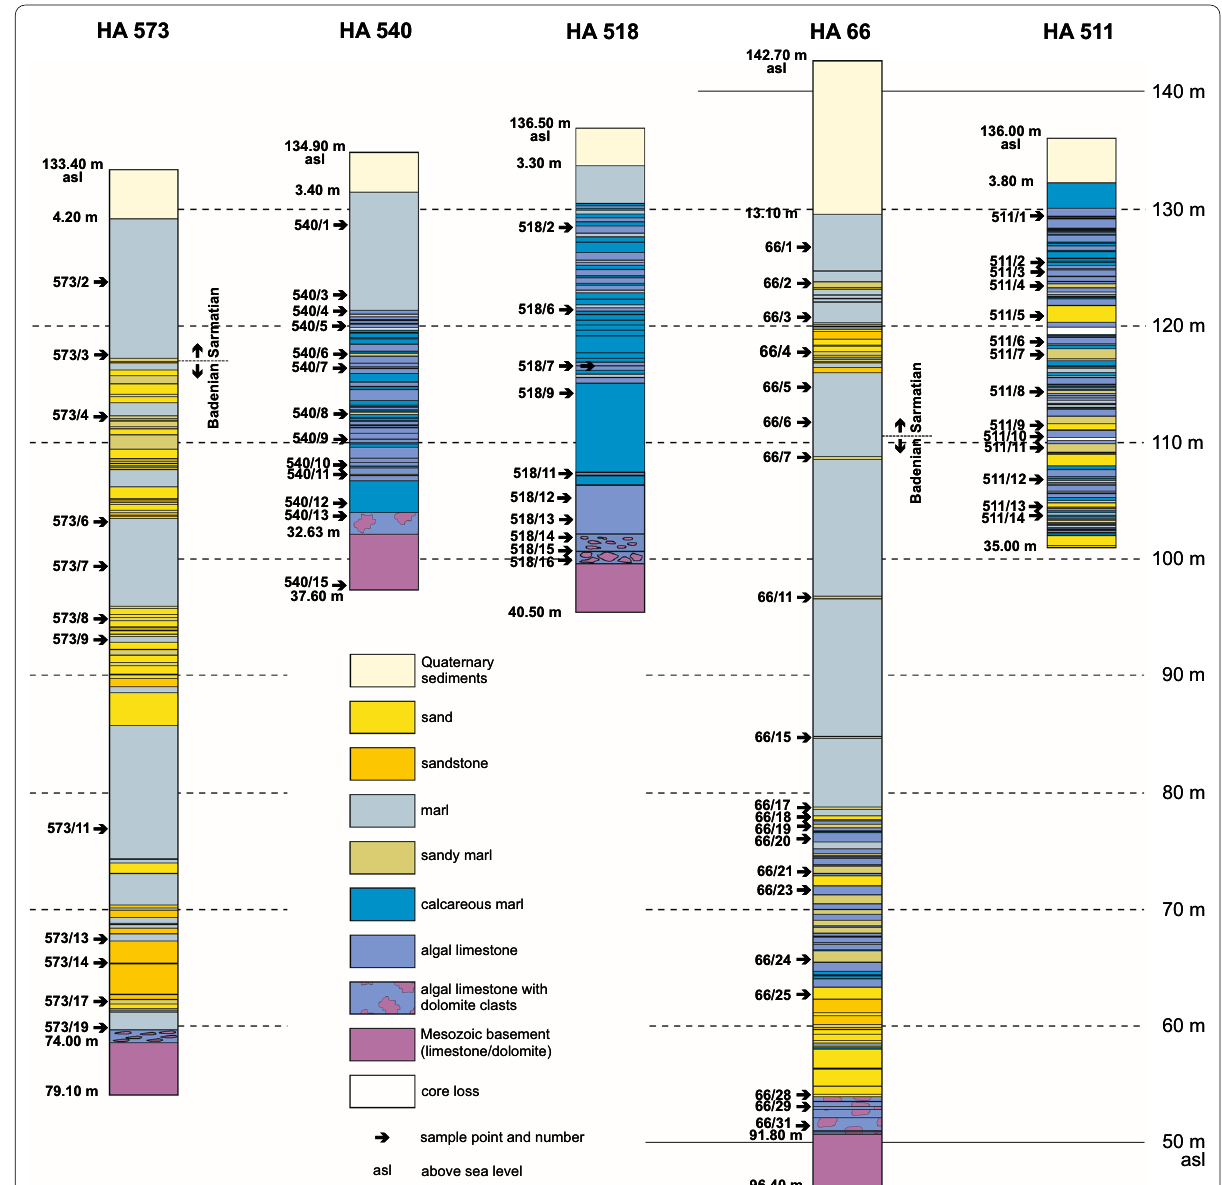
Fig. 4 Lithologs of the detailed studied cores arranged according to their position in respect to altitude (asl) and roughly perpendicular to the axis of the Mesozoic ridge. Indicated for all drillings are sample locations (arrow), altitude above sea level (asl), depth of the Quaternary, depth of Mesozoic basement (if reached) and final